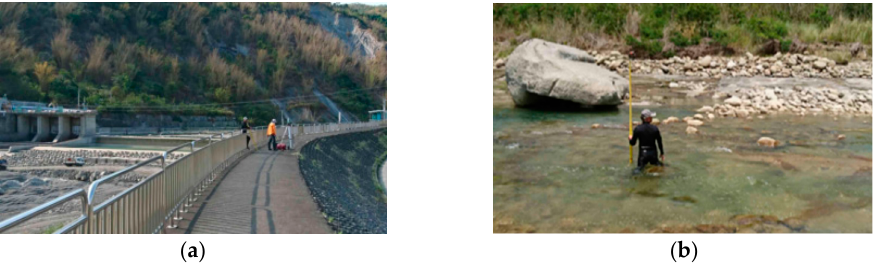
Figure 4. The pictures taken while surveying the cross-section of the study area in 2017. ( a ) was setting up the ground control point for RTK adjustment, and ( b ) was surveying the cross-section of the upstream of the Jiashian river weir.